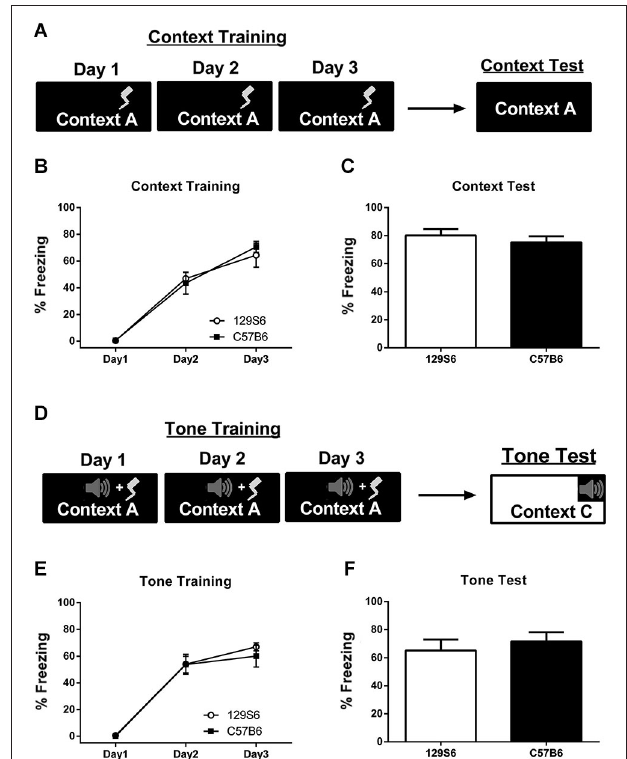
FIGURE 1 | Inbred mouse strains, 129S6 and C57B6, have comparable levels of fear acquisition and consolidation . (A) Schematic representation of context fear conditioning. Mice were trained to a context or tone using 3 unsignaled footshocks or 3 tone-shock pairings per day for 3 days. Acquisition of fear across training is represented as the average percent freezing to the context or tone prior to shock for each day. Mice were tested 24 h later. (B) The 129S6 mice ( n = 7) showed a significant increase in freezing across context training days comparable to that seen in C57B6 mice ( n = 8). (C) During testing, both 129S6 and C57B6 mice show high levels of freezing to the context, not significantly different from each other. (D) Schematic represention of tone fear conditioning. (E,F) Similar results were obtained when 129S6 and C57B6 mice ( n = 4 and 4 respectively) were conditioned to a tone and tested 72 h later. Data are presented as mean ± SEM. * p <